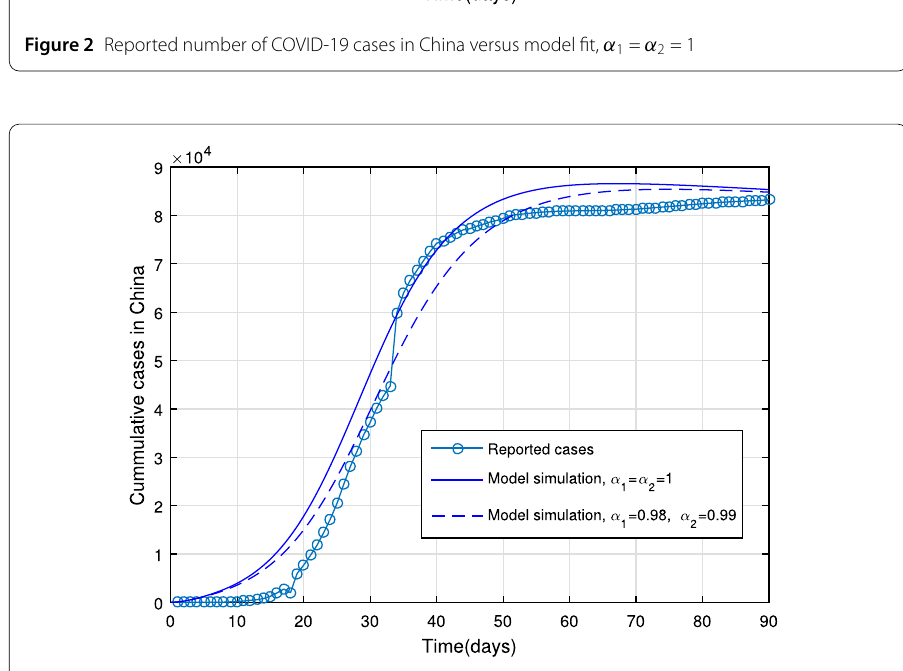
Figure 3 Reported number of COVID-19 cases in China versus model fit, α 1 = 0.99, α 2 =